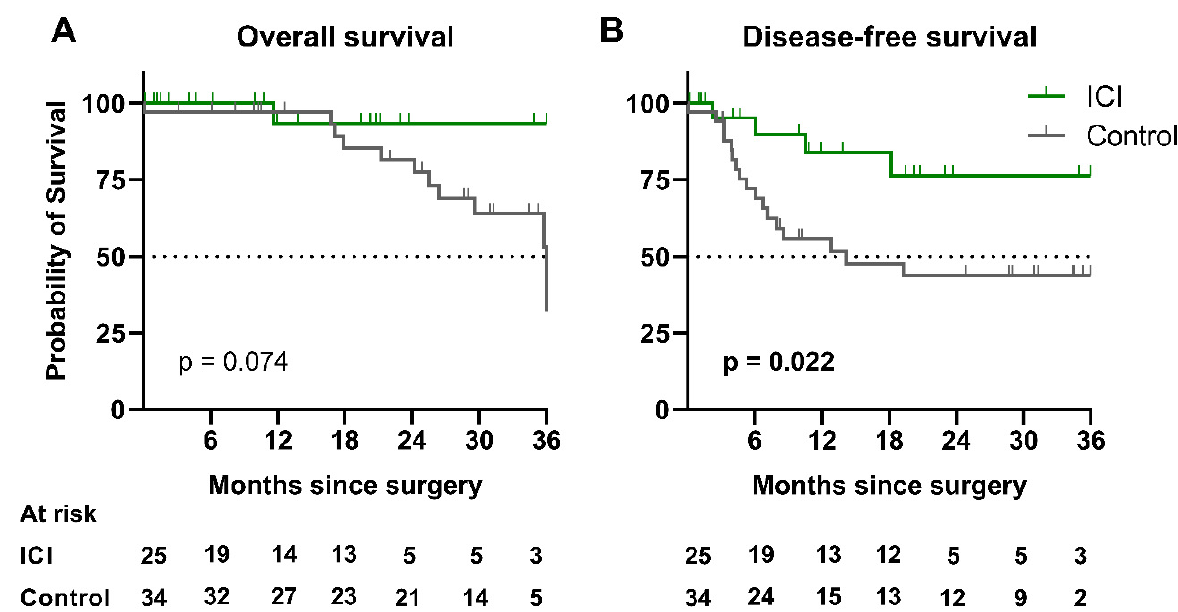
Figure 5. Three-year survival analyses in the study population. ( A ) Kaplan–Meier curves of 3-year overall survival in patients of the ICI group versus the control group. ( B ) Kaplan–Meier curves of 3-year disease-free survival in both groups. Abbreviation: ICI: immune checkpoint inhibitors.